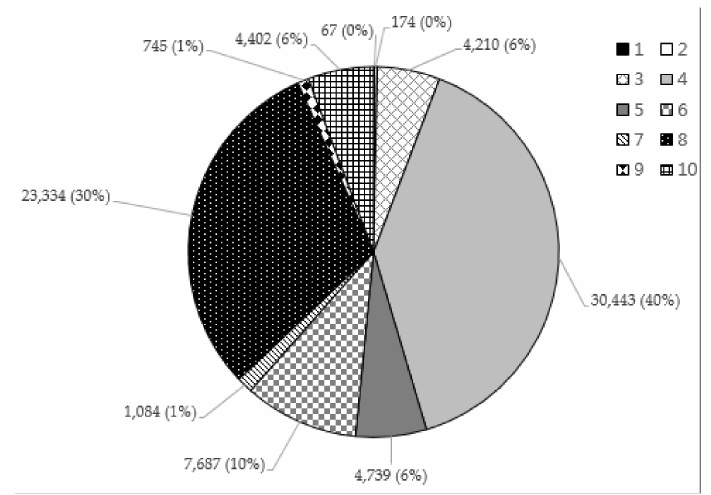
Figure 7. Proportion of the error